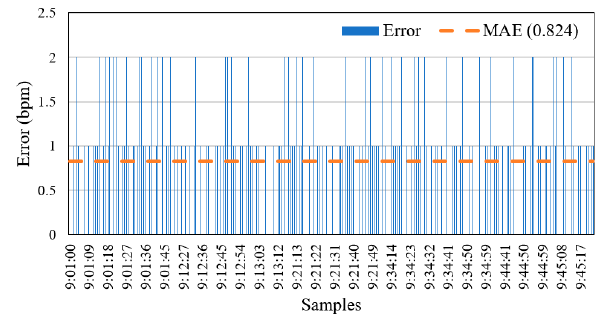
Figure 12. Mean absolute error values for heart rate data from five elderly volunteers, aged 61 to 65 years old.